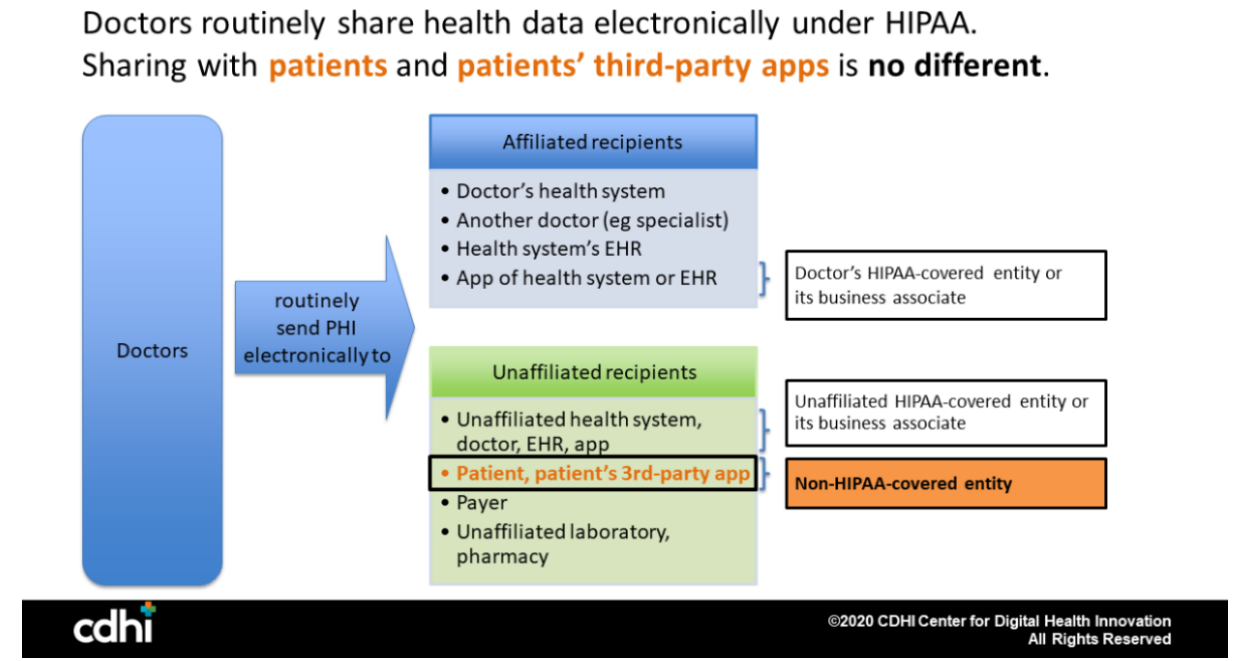
Figure 2. Routine data sharing with Health Insurance Portability and Accountability Act of 1996 (HIPAA)-covered and non-HIPAA–covered